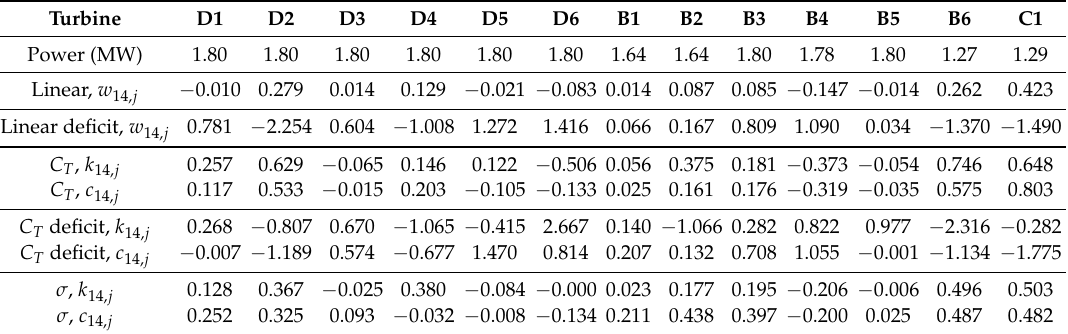
Table A1. Input–output training example for the various statistical models proposed in Section 2. One one-minute averaged data training example is shown. The inflow is from 250 ◦ ± 5 ◦ . The turbine of interest is C2, which is the 14th turbine downwind for inflow from this